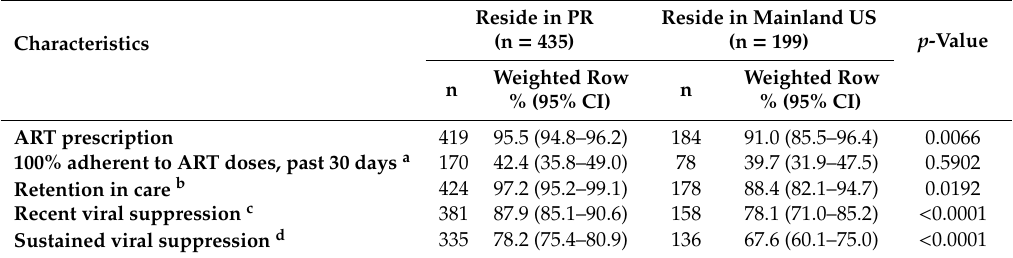
Table 4. HIV outcomes among Puerto Rico-born Hispanic / Latino adults with diagnosed HIV by current residency, United States—Medical Monitoring Project, 2015–2018 (n =